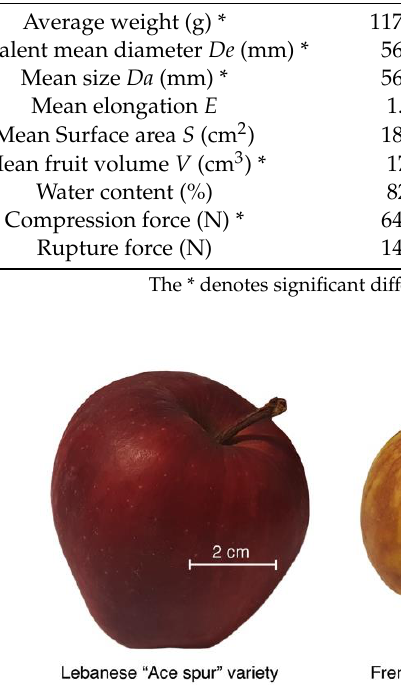
Figure 3. Morphological aspects of the Lebanese “Ace spur” and the French “Kermerrien” apple varieties. Table 1. Average fruit weight, linear dimensions, size, elongation, and rheological properties of 25 apples taken from “Ace spur” and “Kermerrien” vartieties.